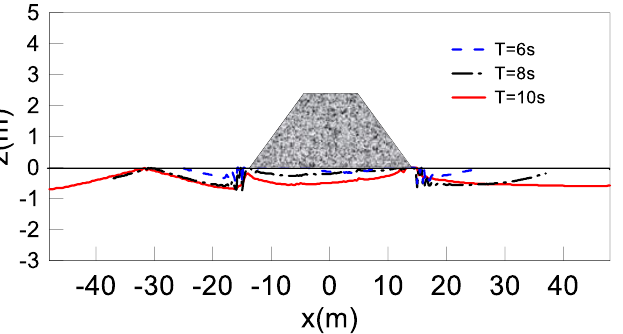
Figure 9. Development of liquefaction potential around the breakwater with various wave